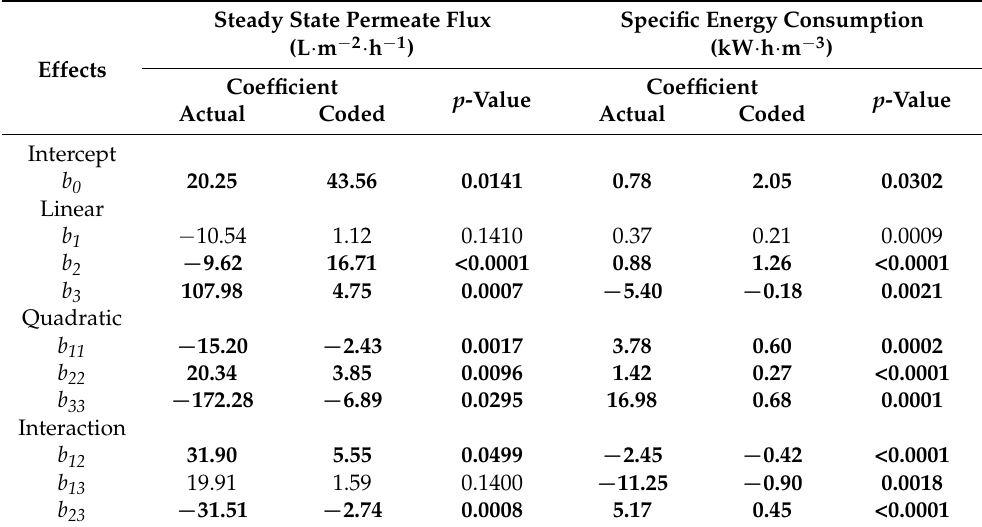
Table 2. Coefficients of regression models for steady state permeate flux and specific energy